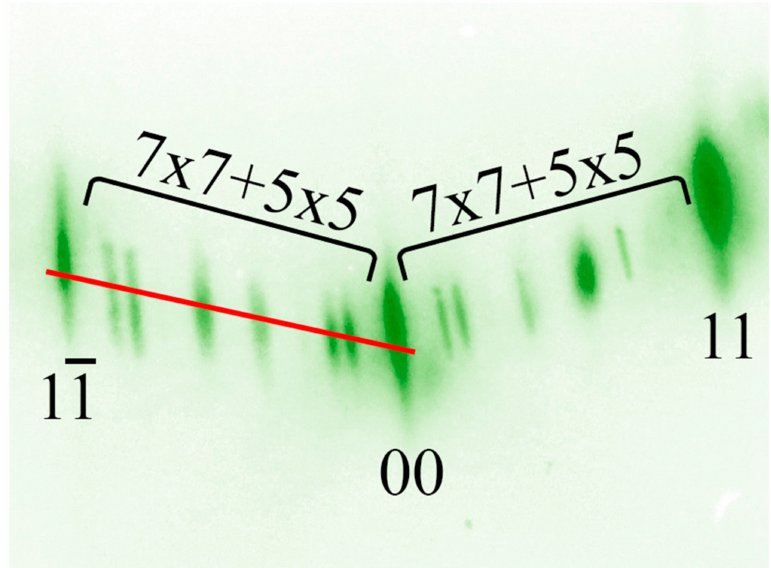
Figure 6. Diffraction pattern from the germanium layer on Si(111) at the moment of the transition from the 7 × 7 to 5 × 5 superstructure. Red line indicates the profile for the subsequent analysis.